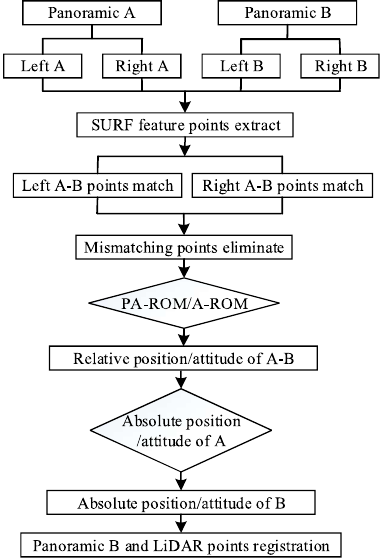
Figure 1. Flow chart of our registration method.